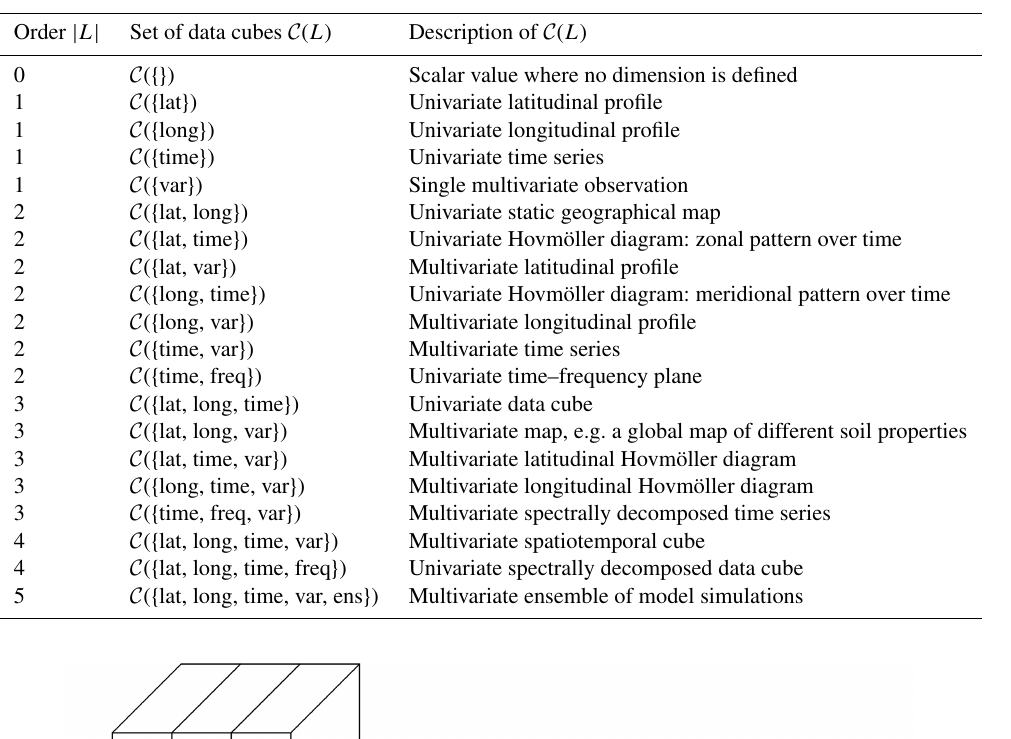
Table 1. Typical sets of data cubes C ( L ) of varying orders | L | with characteristic dimensions L .